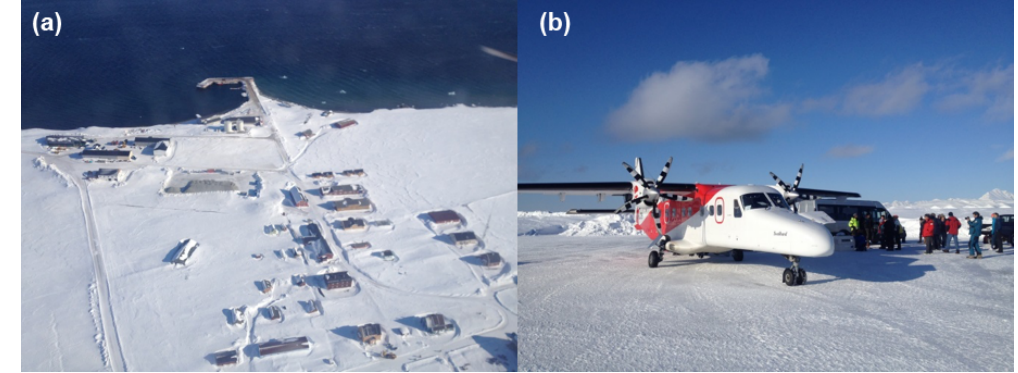
Figure 1. View on Ny Ålesund from a plane (a) and a small airplane on airstrip of Ny Ålesund (b) . Credits: Alexey Pavlov (Norwegian Polar